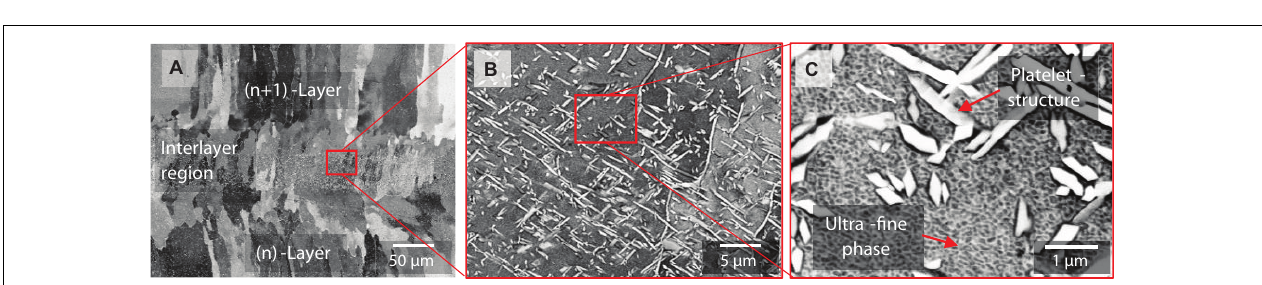
FIGURE 5 | Sample cross-sections of B samples produced with 450 ◦ C pre-heating temperature and different track lengths and sample height. 10:10 mm cross-section samples with 15 mm track length (A,B) and 35 mm track length (C,D) as opposed to 35:10 mm cross-section and 10 mm track length (E) . Cracks occur for the longer track length.